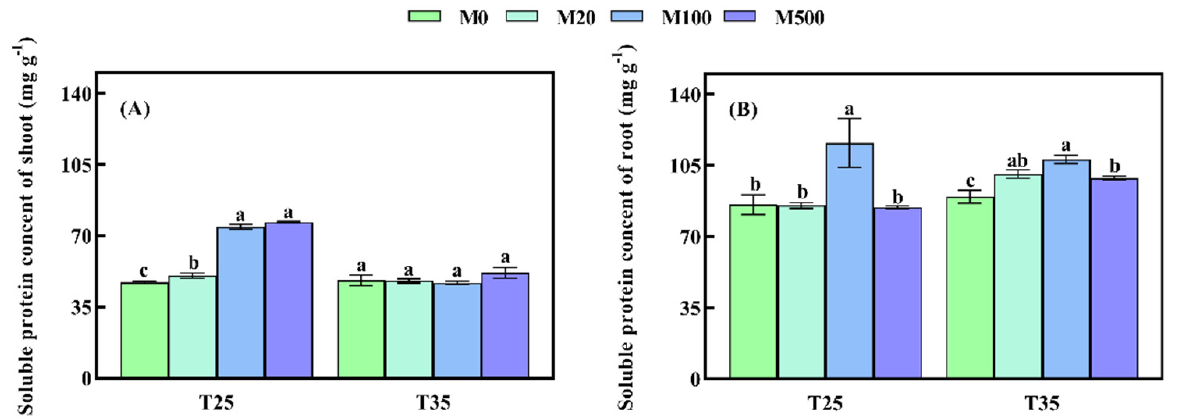
Figure 6. Effect of exogenous melatonin on the soluble protein content of rice seed shoots and roots under drought stress. Means ± SEs with different letters in each parameter indicate significant statistical differences (LSD, 0.05). ( A ) Soluble protein content of shoot; ( B ) soluble protein content of root.